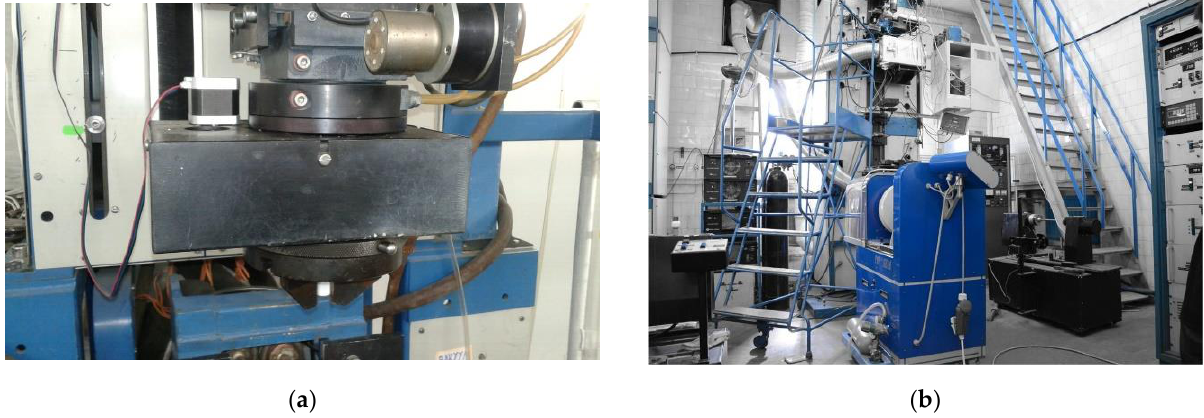
Figure 2. Modifications of drawing tower: ( a ) general view of the drawing tower feed unit; ( b ) general view of drawing tower.